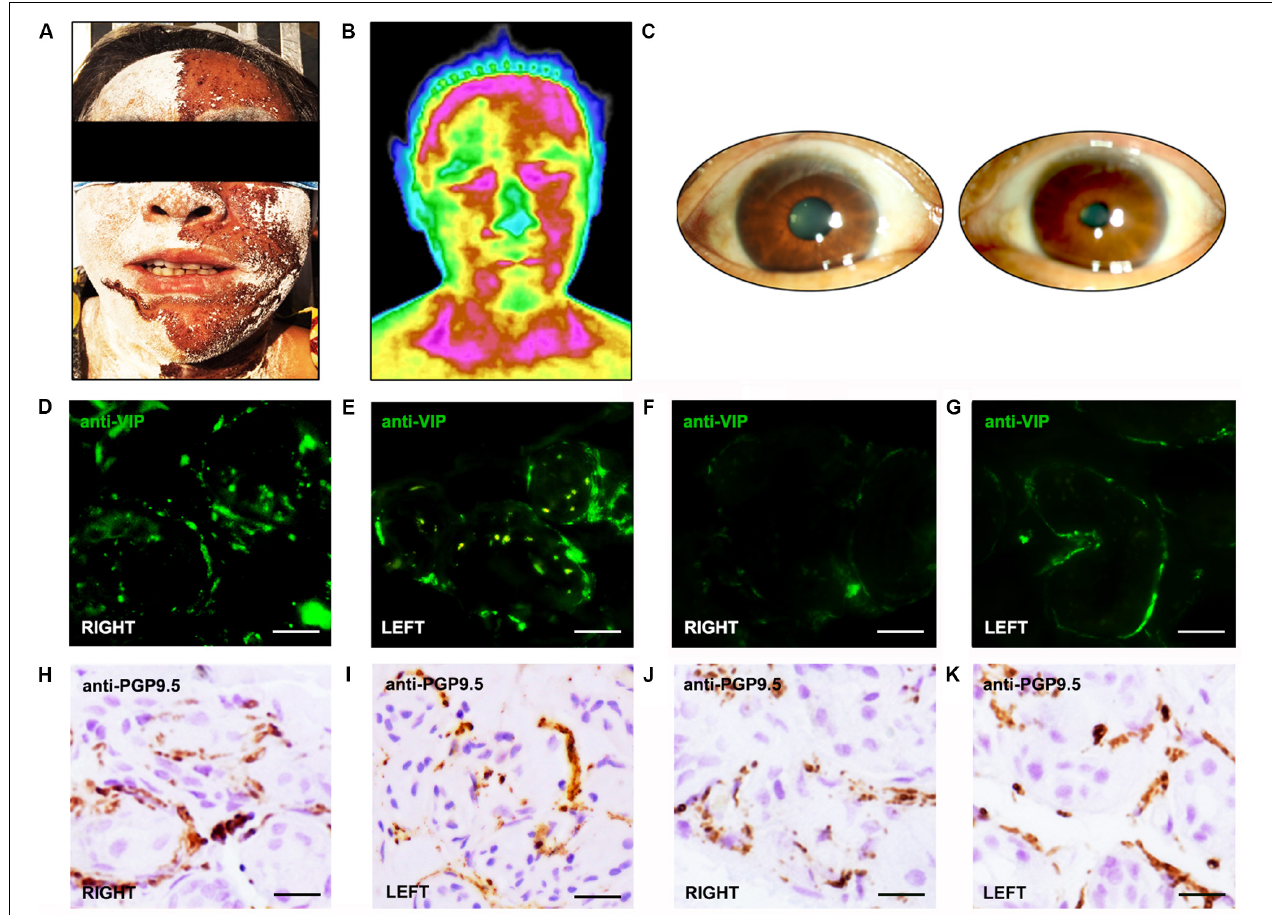
FIGURE 1 | Morphologic and functional features of patients and normal controls. (A) Thermoregulatory sweat test (iodine-starch method). Hypohidrosis is seen mainly on the right side of the face. (B) Digital infrared thermal imaging shows a lower temperature in the left side of the face than the right. (C) Pupillary light reflex appears sluggish in the right eye, but normal in the left eye. (D–G) VIP immunoreactive fibers appeared more frequently in the skin of normal controls (D,E) than in Ross patients (F,G) . In Ross patients, rare VIP immunoreactive fibers were found around sweat glands in anhidrotic skin (F) , while VIP-ir fibers appeared more frequently in hyperhidrotic skin (G) . (H–K) . The PGP 9.5-ir fibers appeared more frequently in the skin of normal controls (H,I) than in Ross patients (J,K) . In Ross patients, the PGP 9.5-ir fibers were severely reduced in anhidrotic skin (J) and slightly reduced in hyperhidrotic skin (K)